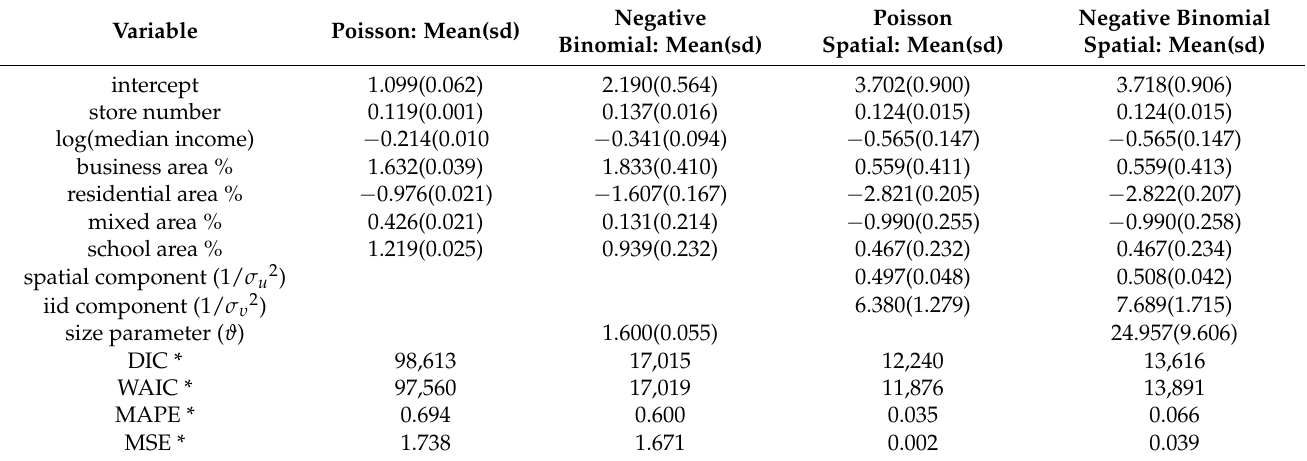
Table 2. Posterior means and standard deviations (sd) for four Bayesian hierarchical models.